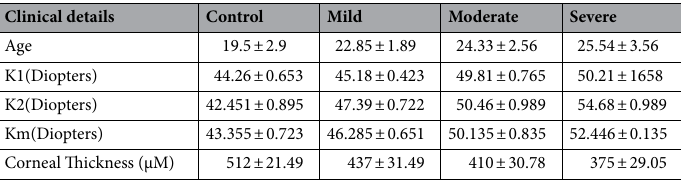
Table 1. Patient details age, keratometry and pachymetry, Km- Mean keratometry reading in